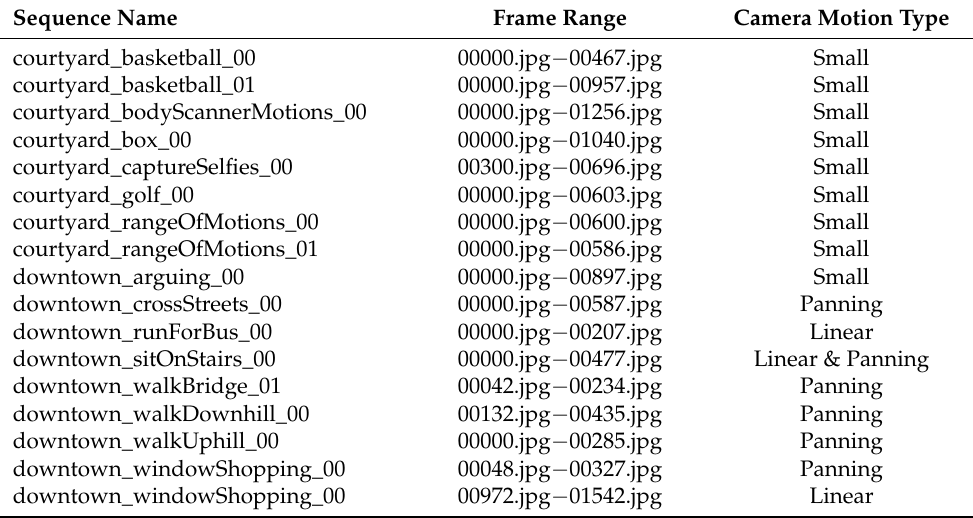
Table 1. Details of the processed 3DPW